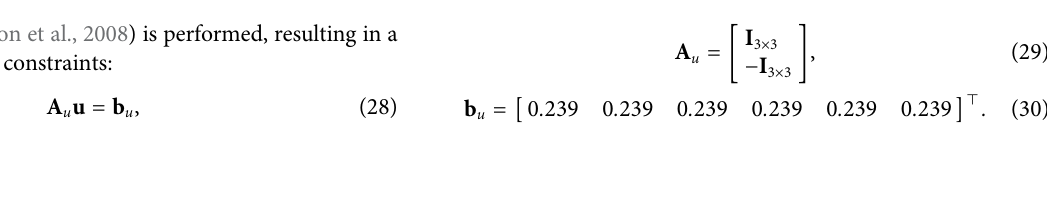
Frontiers in Robotics and AI |